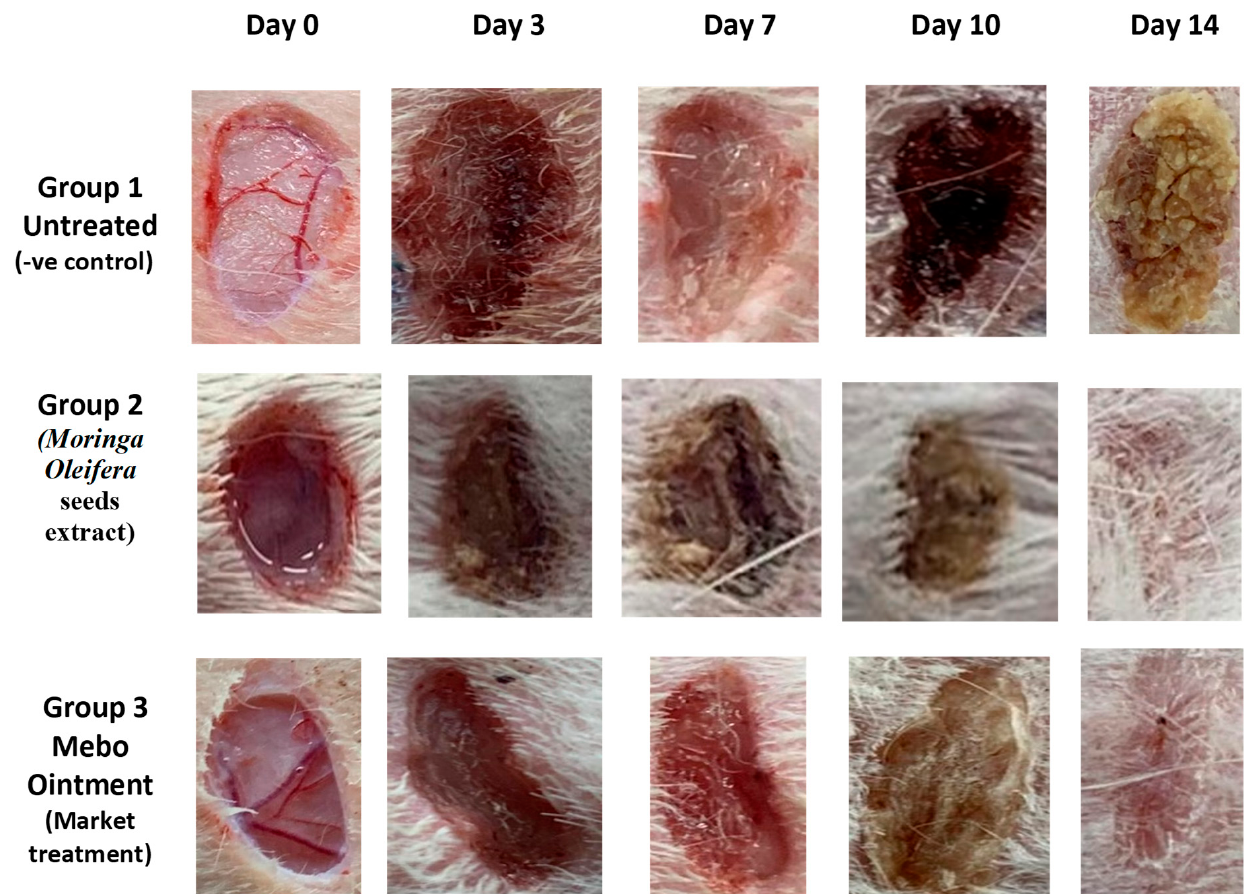
Figure 1. The wound healing potential of Moringa oleifera seeds extract compared to MEBO ® in excisional wounds on days 0, 3, 7, 10, and 14 post wounding. Rabbits were divided into three groups: group 1 was left untreated (-ve control), group 2 received Moringa oleifera seeds extract, and group 3 received MEBO ® (market treatment- + ve control).